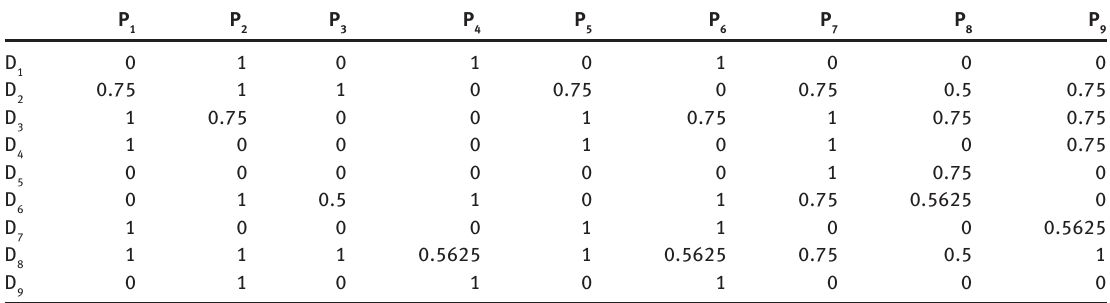
Table 5: Disease-Patient Confirmability Indication Matrix (p × d) (Case Study Example). P P 1 2